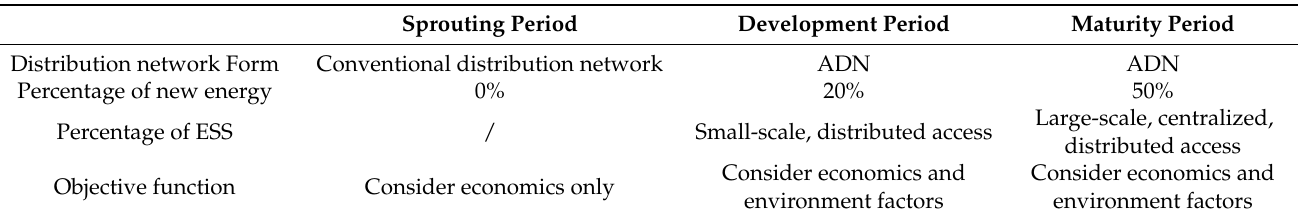
Table 1. Comparison of characteristics of three typical morphological evolution periods of transmis- sion and distribution